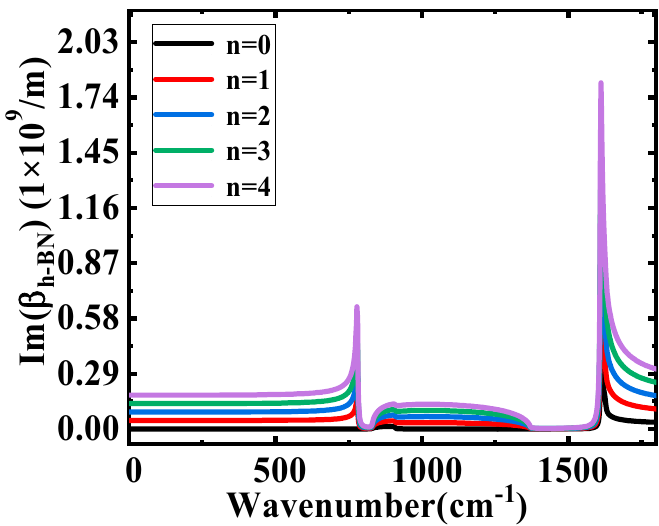
Figure 3. Im( β h ‐ BN ) as a function of wavenumber. Figure 3. Im( β h-BN ) as a function of